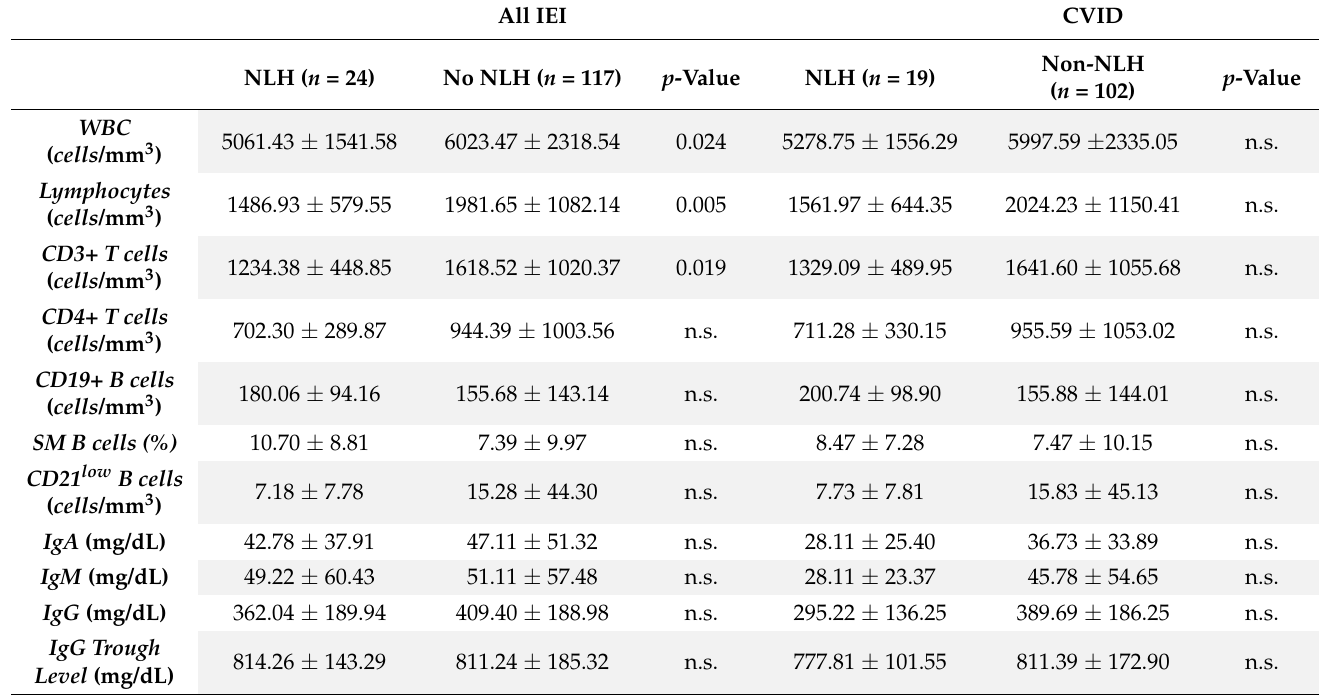
Table 6—IEI= inborn errors of immunity; CVID = common variable immunodeficiency; NLH = nodular lym- phoid hyperplasia; WBC = white blood cells; SM B cells = switched memory B cells; IgG = immunoglobulin